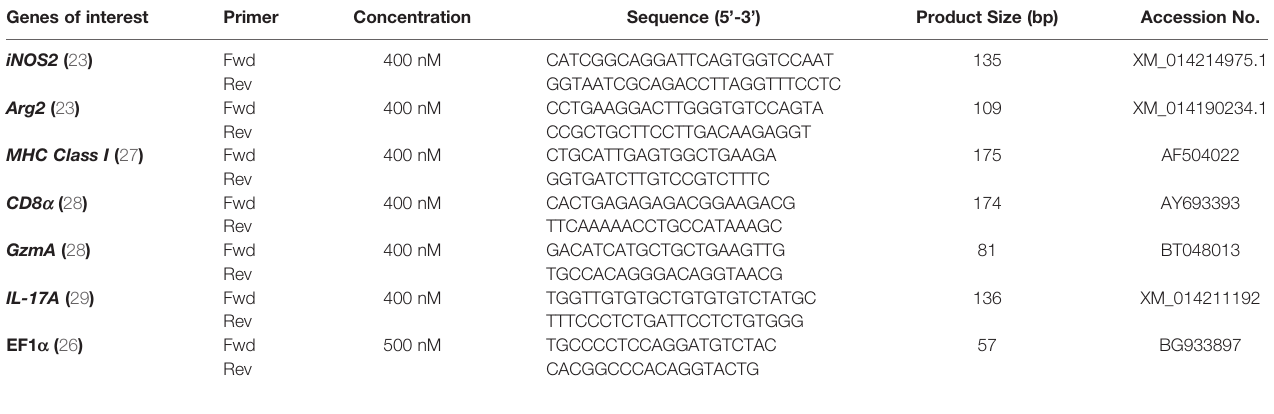
TABLE 1 | List of primers used in quantitative PCR